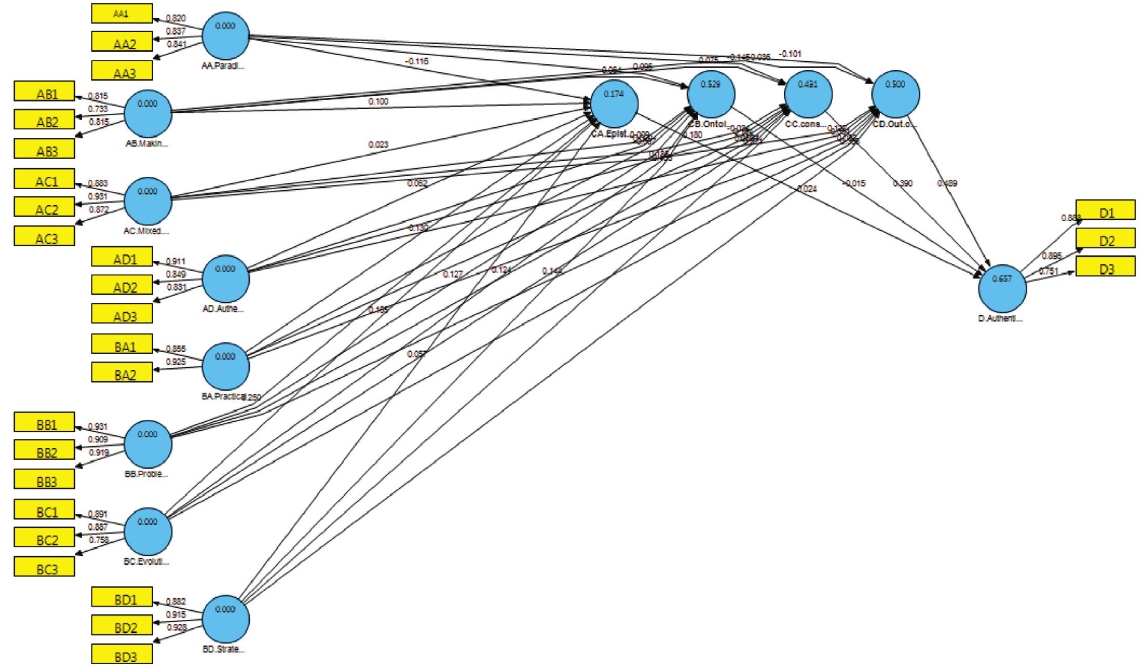
Figure 4: The external model of second-order hypotheses in the general standard state.